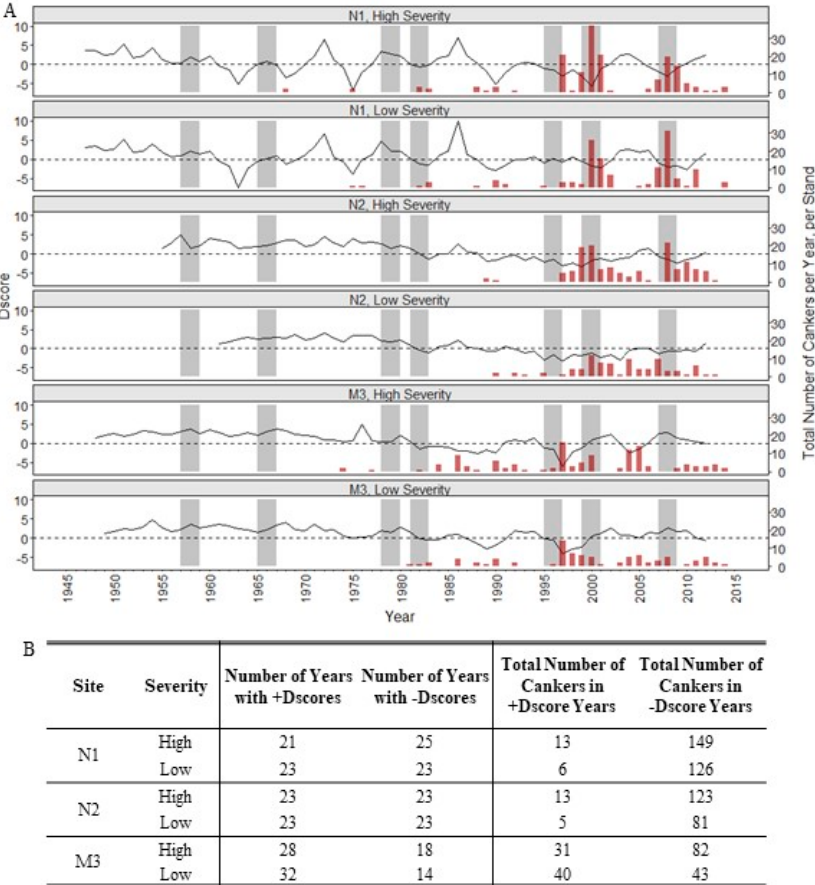
Figure 6. Decline scores (D scores ) associated with annual number of cankers, separated by site and Caliciopsis symptom severity class. ( A ) Black solid lines represent annual D scores (averaged per severity class and site). Black horizontal dashed lines represent the decline cutoff; D scores < 0 are declining stands. Gray vertical bars represent specific climatic events plus a 2-year post-event window (1957–1959, 1965–1967, 1978–1980, 1981–1983, 1995–1997, 1999–2001, 2007–2009). Red vertical bars represent the total number of cankers per severity class, per site, per year. ( B ) The sum of years and number of cankers in both positive and negative D score years, for 1967–2012.